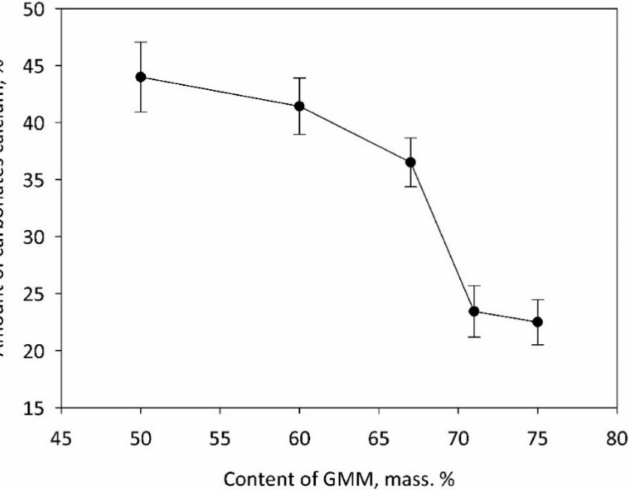
Figure 6. The changes in the concentration of carbonates calcium depending on the content of the modifier in the model